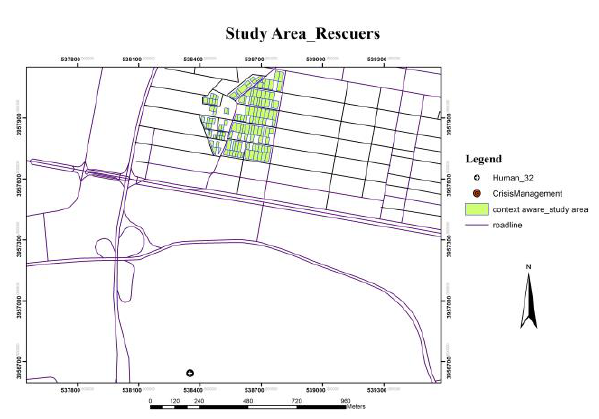
Figure 2: Study area and the first location of rescuers The following figure shows the structure of the relief and rescue operations, based on the context information provided by the rescuers and the senses.